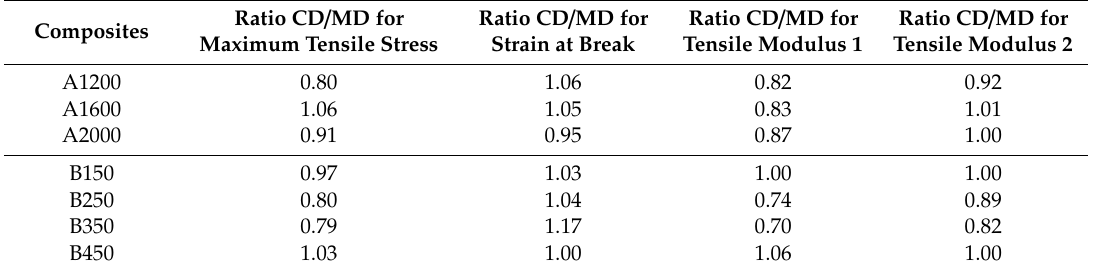
Table 3. Ratios of tensile anisotropy of nonwoven composites.